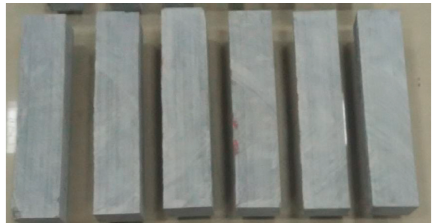
Figure 2: The limestone sample geometry.